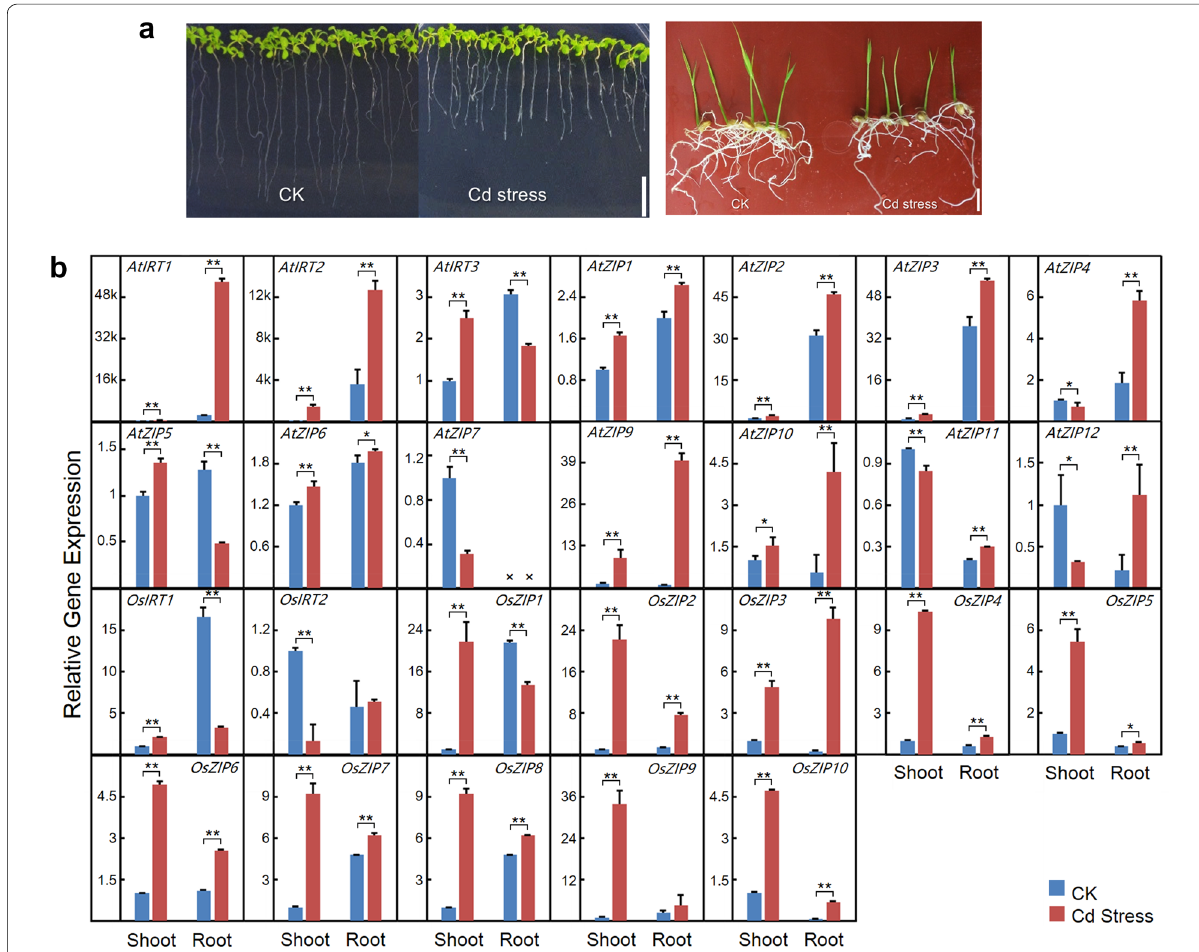
Fig. 2 Expression profiles of ZIP genes of Arabidopsis and rice in response to Cd stress. a 1-week-old and 10-day-old seedlings of Arabidopsis and rice were treated with 300 μM CdCl 2 for 3 days. Scale bars indicate 1 cm. b Changes in the expression of the 26 ZIP genes in response to Cd exposure Gene expression level was normalized using shoot expression level of each gene in the controls as the calibrator. (n *indicates P < 0.05, **indicates P <